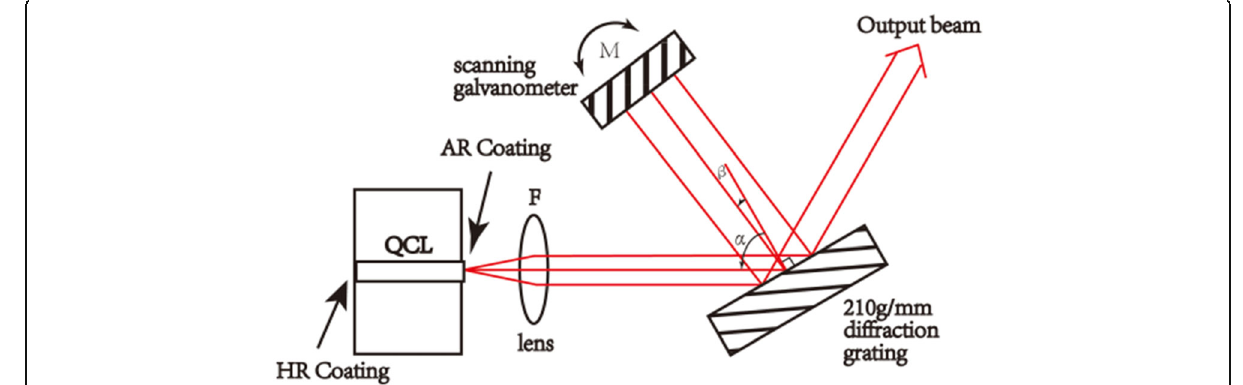
Fig. 1 Schematic of Littman-Metcalf external cavity configuration